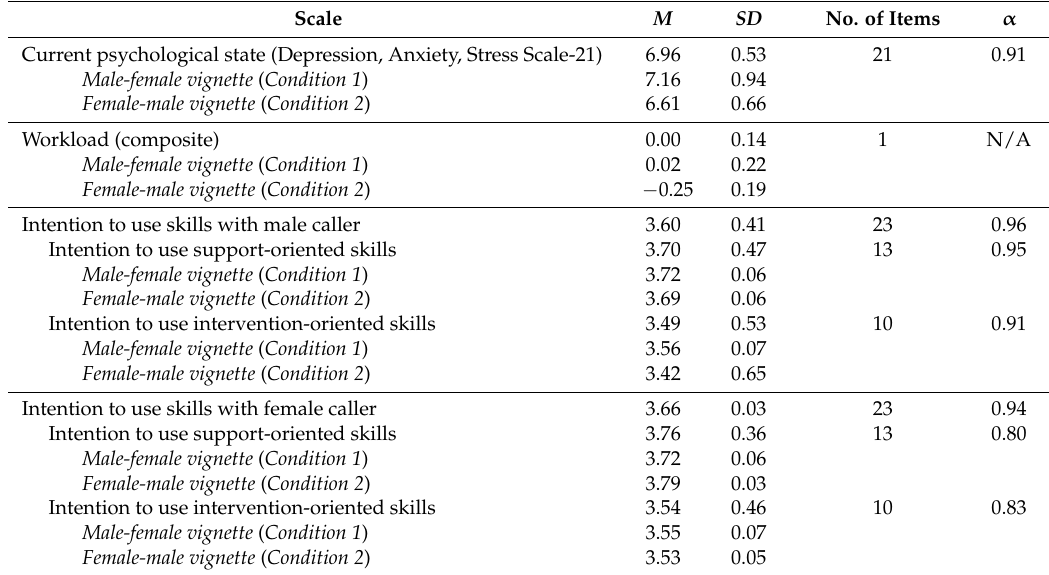
Table 3. Descriptive statistics and reliability estimates of study